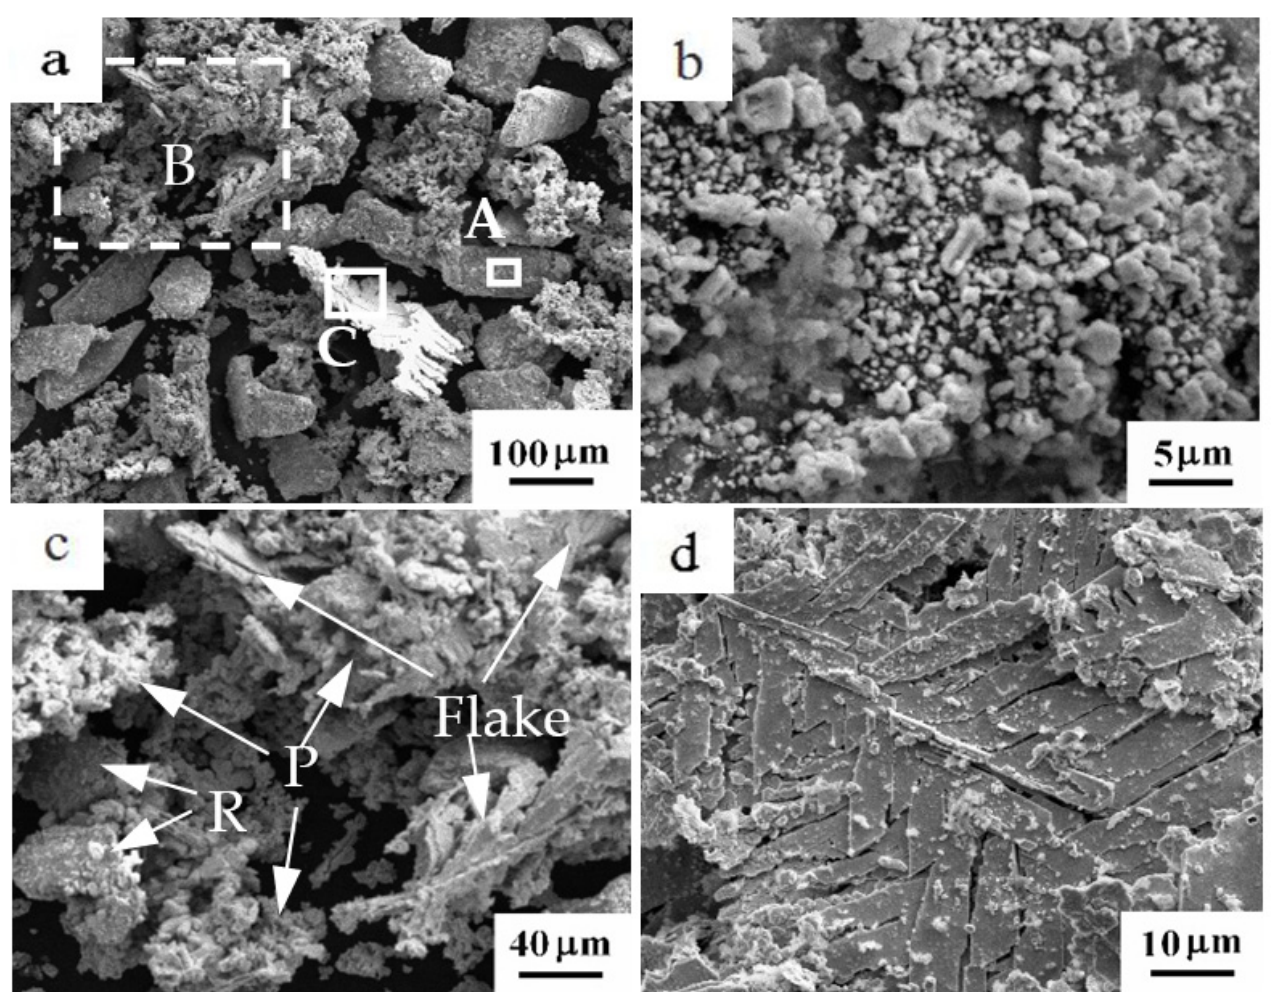
Figure 14. ( a ) SEM images with different magnifications of the reacted FeSiB BP and ( b – d ) enlarged views of the corresponding regions A, B, and C, respectively.